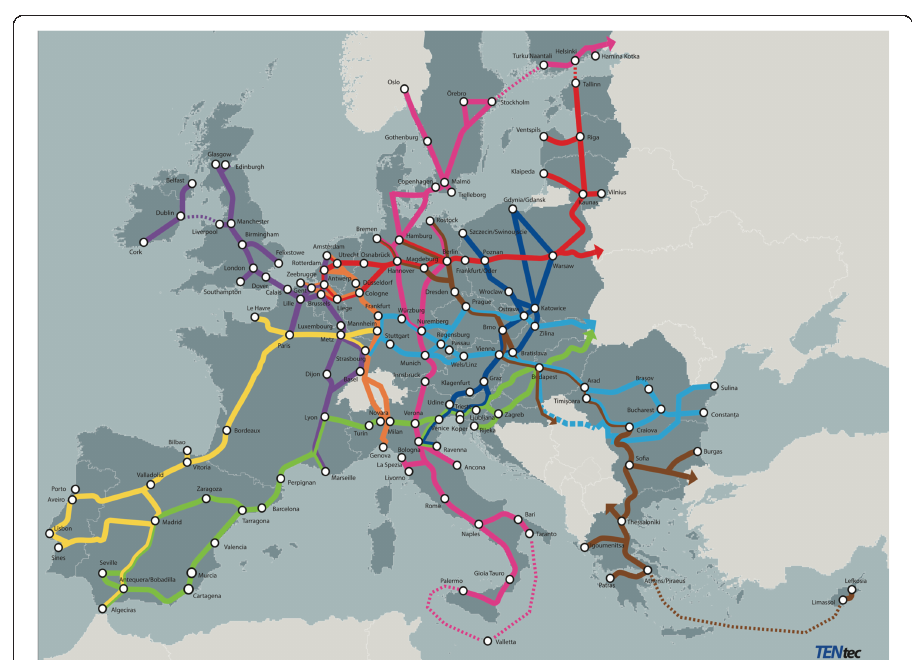
Fig. 5 TEN-T Core Network Corridors (European